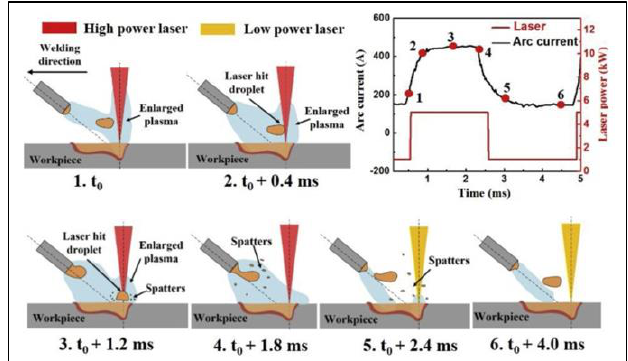
Figure 24. The droplet transfer behavior in in-phase LAHW [110]. Reprinted with permission from [110] 2020 Elsevier.